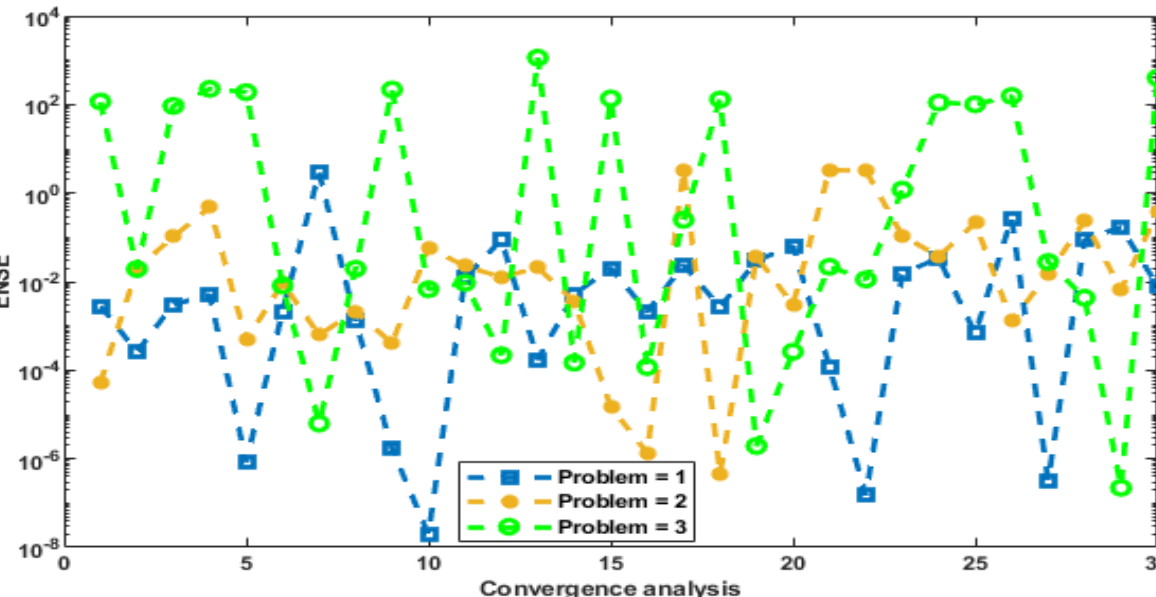
Figure 7. Convergence performance of ENSE for each problem of the HO-NSDM. Table 3. Complexity performances for each problem of the HO-NSDM.